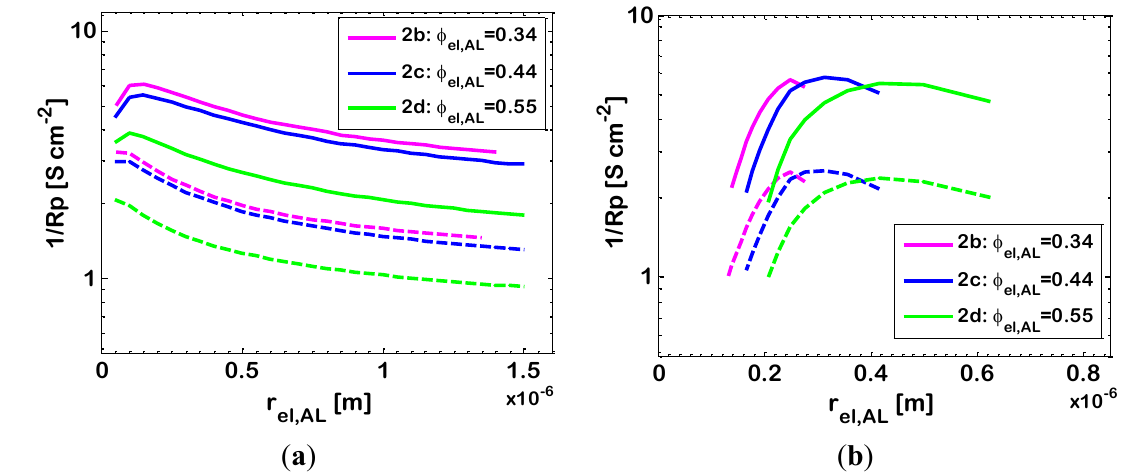
Figure 7. Effect of AL Ni particle radius r Temperatures: T = 973 K (dashed lines) and T = 1073 K (solid lines); other data in Table 2. Varying parameter: Ni volumetric fraction in the AL (ϕ varied together with r 0.25 μm through all the simulations